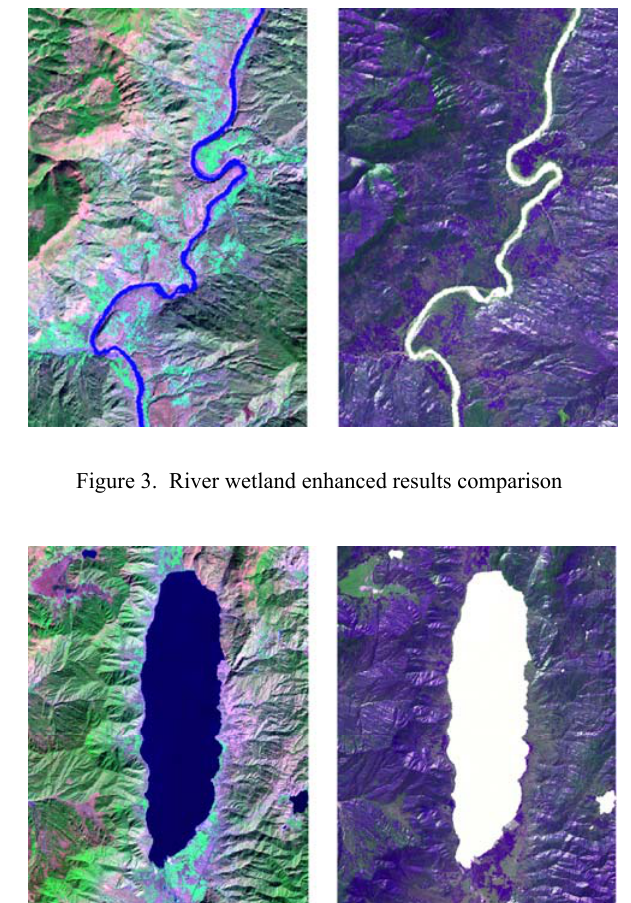
Figure 4. Lake wetland enhanced results comparison